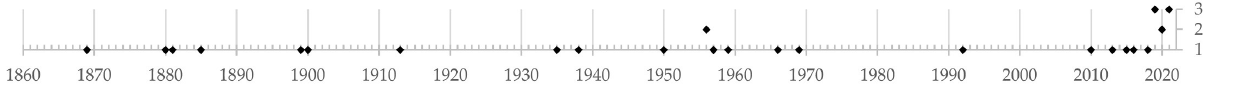
Figure 2. The monthly dispersal of Sowerby’s beaked whale ( Mesoplodon bidens ) records, in the Skagerrak basin and adjacent waters, 1860–2021. The record of skeletal remains from June 2010 is not included, since the month of death is unknown.